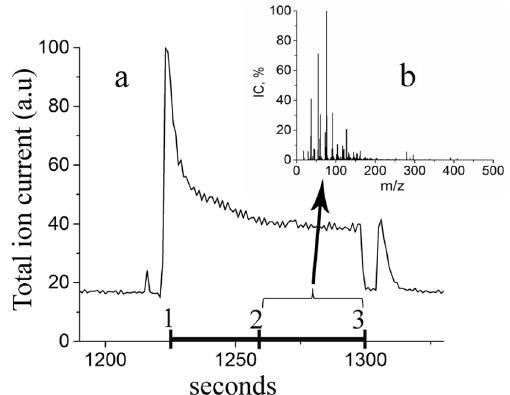
Figure 2. ( a ) Time dependence of the total ion current (sample 8379) and ( b ) cumulative mass spectrum of the sample.